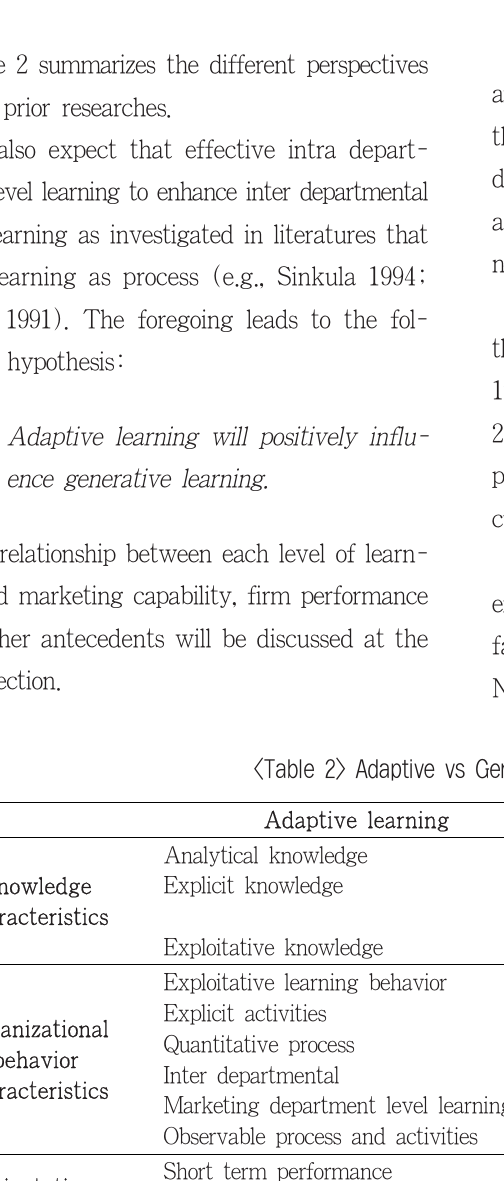
Table 2 summarizes the different perspectives of the prior